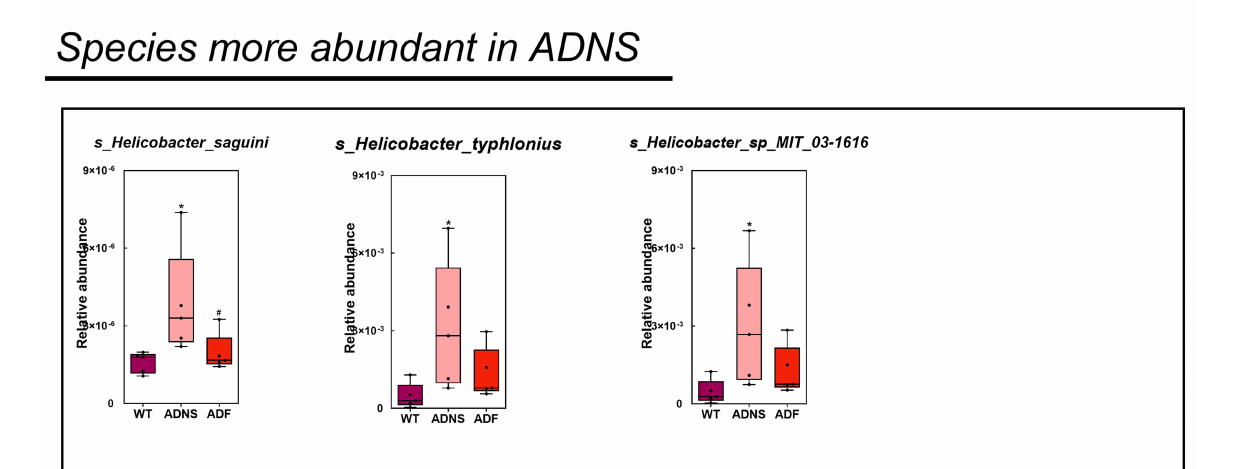
fructose and mannose, citrate cycle (TCA cycle), amino sugar, and nucleotide sugar; the 335 differential metabolites in ADNS vs. ADF were concentrated in 20 signaling